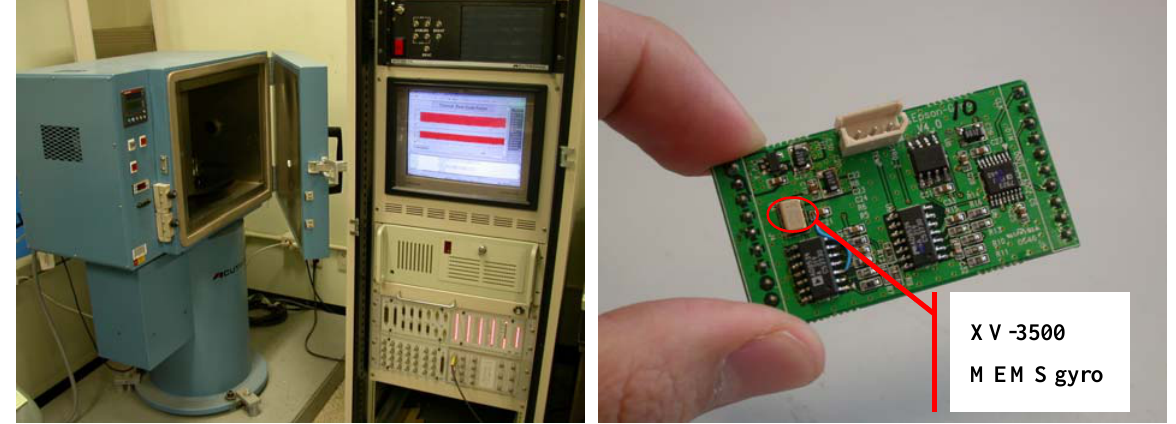
Figure 1. Rate/positioning table and Epson XV3500 gyro